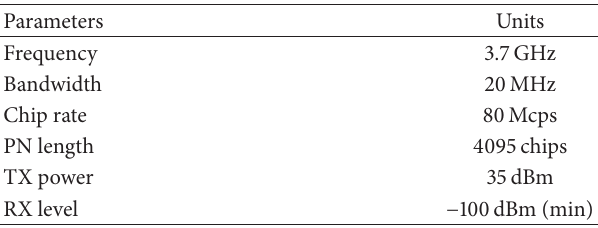
Table 1: Measurement system parameters.